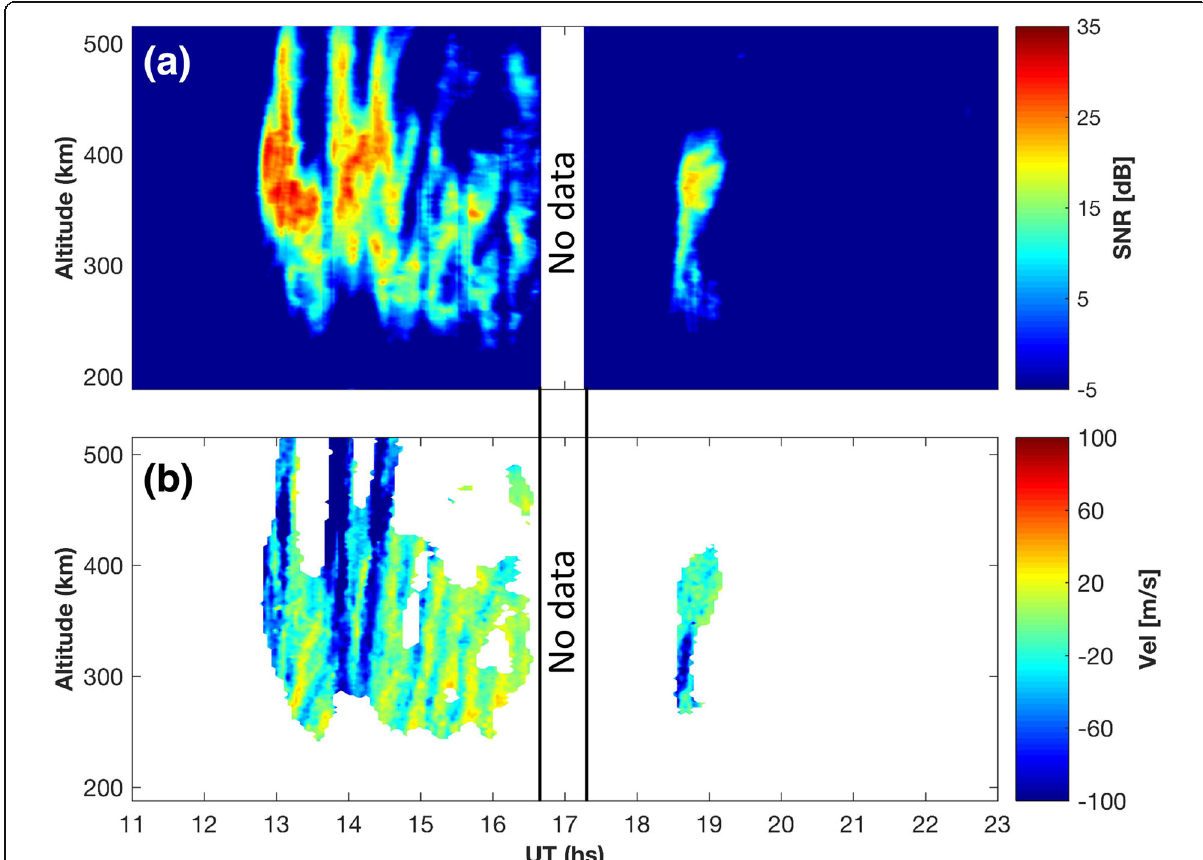
Fig. 2 a Altitude-time-intensity (ATI) and b altitude-time-velocity (ATV) maps of F-region field-aligned irregularities (FAIs) observed by central beam (azimuth = 180°) of Equatorial Atmosphere Radar (EAR) during 1100 to 2300 UT on 28 July